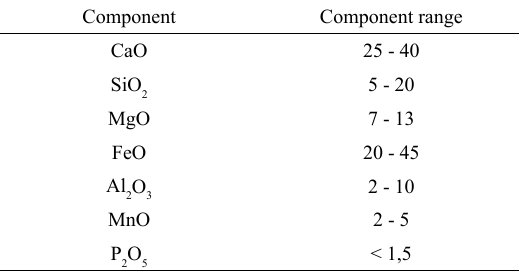
Table 1. Main EAF slag components and final composition % 1 .